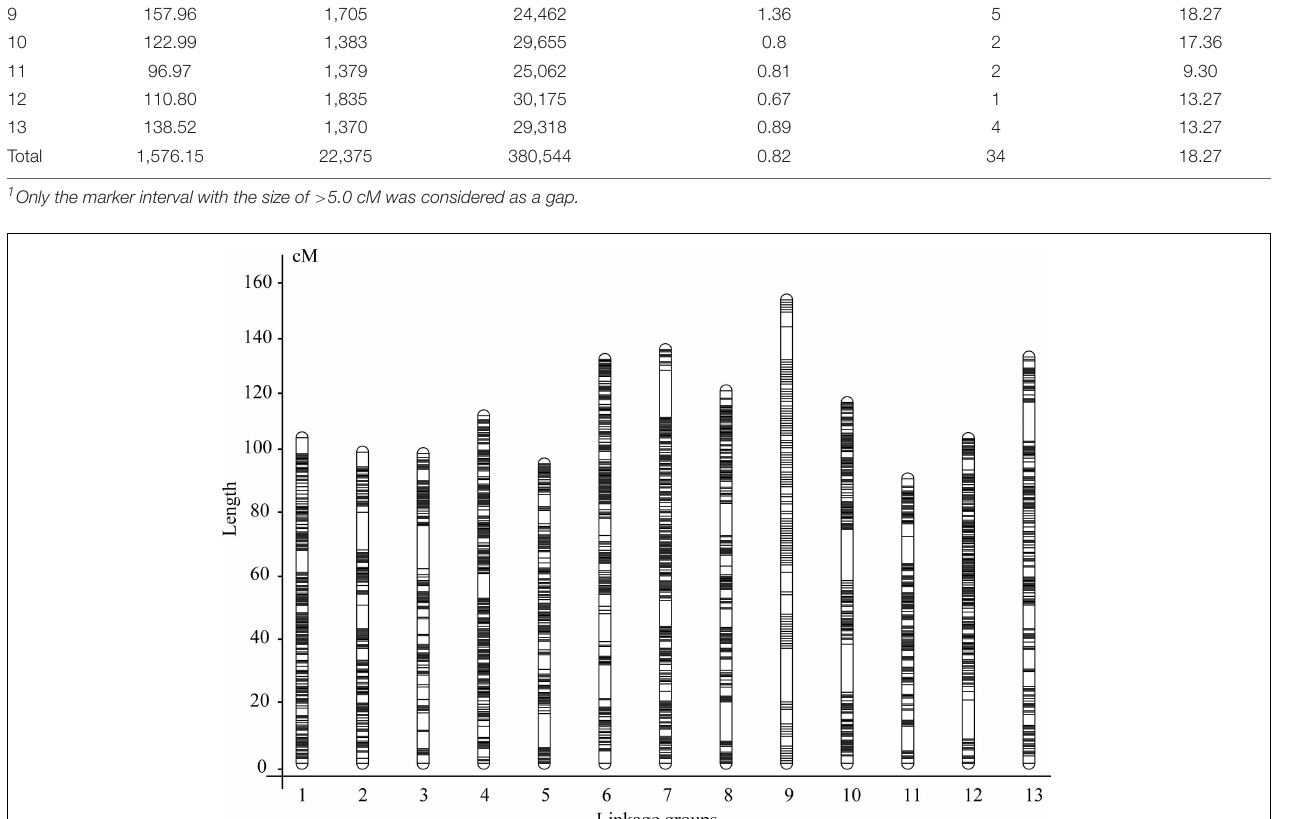
Due to the overlapping positions of the QTLs controlling L